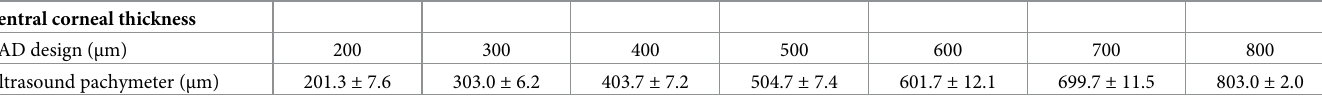
Table 3. Actual value of the central corneal thickness measured using